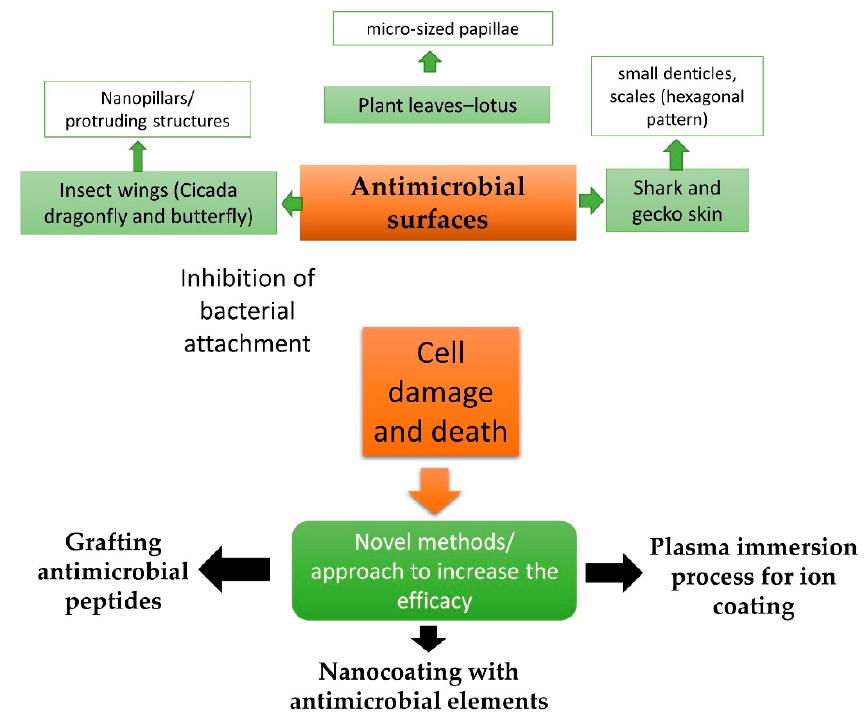
Figure 1. A summary of the progress on antimicrobial